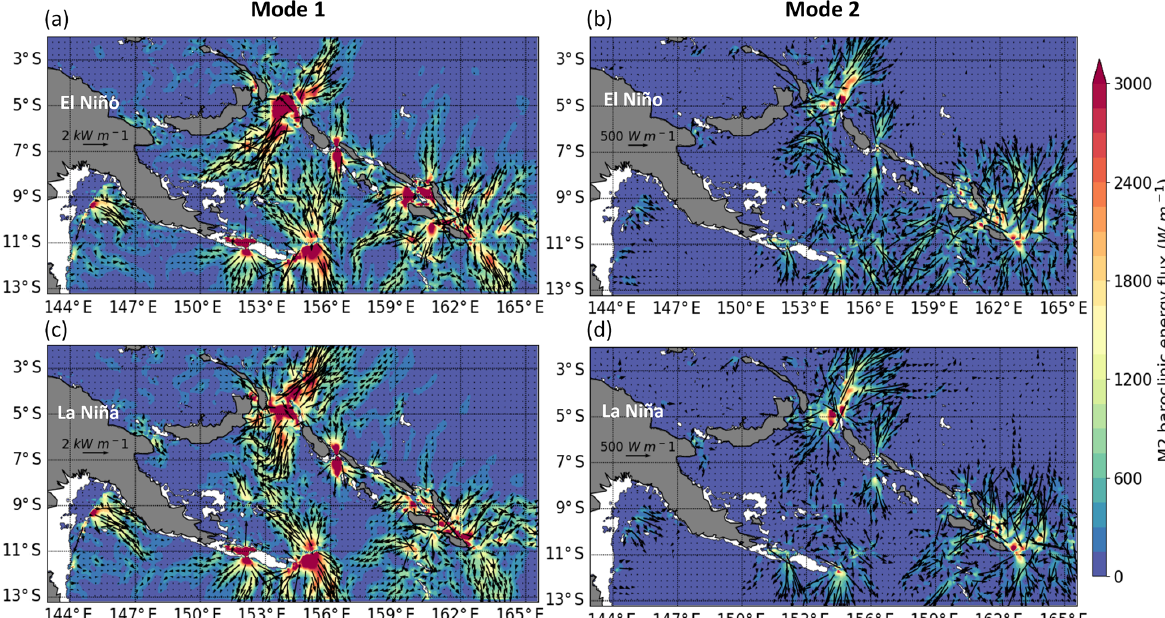
Figure 10. Modal decomposition of the M2 energy flux during the 3-month (a, b) El Niño and (c, d) La Niña periods, corresponding to (a, c) mode 1 and (b, d) mode 2. Mode 1 flux is scaled with arrows of 2kWm − 1 and mode 2 flux with arrows of 500Wm − 1 . The shading is the amplitude (units: watts per meter). Isobathymetric lines are from the NOAA/ETOPO2v2 bathymetric file from the Smith & Sandwell database (https://doi.org/10.7289/V5J1012Q, National Geophysical Data Center, 2006). White color is for bathymetry of less than 50m.